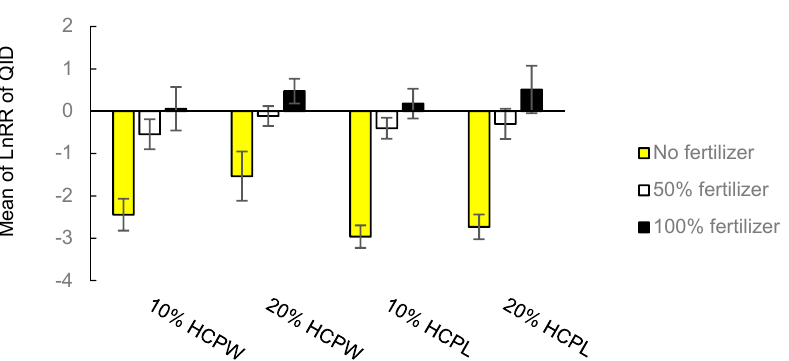
Figure 2. Mean ( ± 95 CI, n = 4) natural logarithmic response ratios (standardized with the untreated full-fertilized control) of Quality Index of Dickson (QID) of pine tree seedlings grown in peat mixed with 10% and 20% (v / v) hydrochar powder (HCPW) and hydrochar pellet (HCPL) in unfertilized (yellow bars), half (open bars) and full fertilized (black bars) conditions. E ff ects of hydrochar type and application rate were considered significant, relative to controls receiving 100% fertilizer, when 95% CI did not overlap with zero in each nutritional regime.